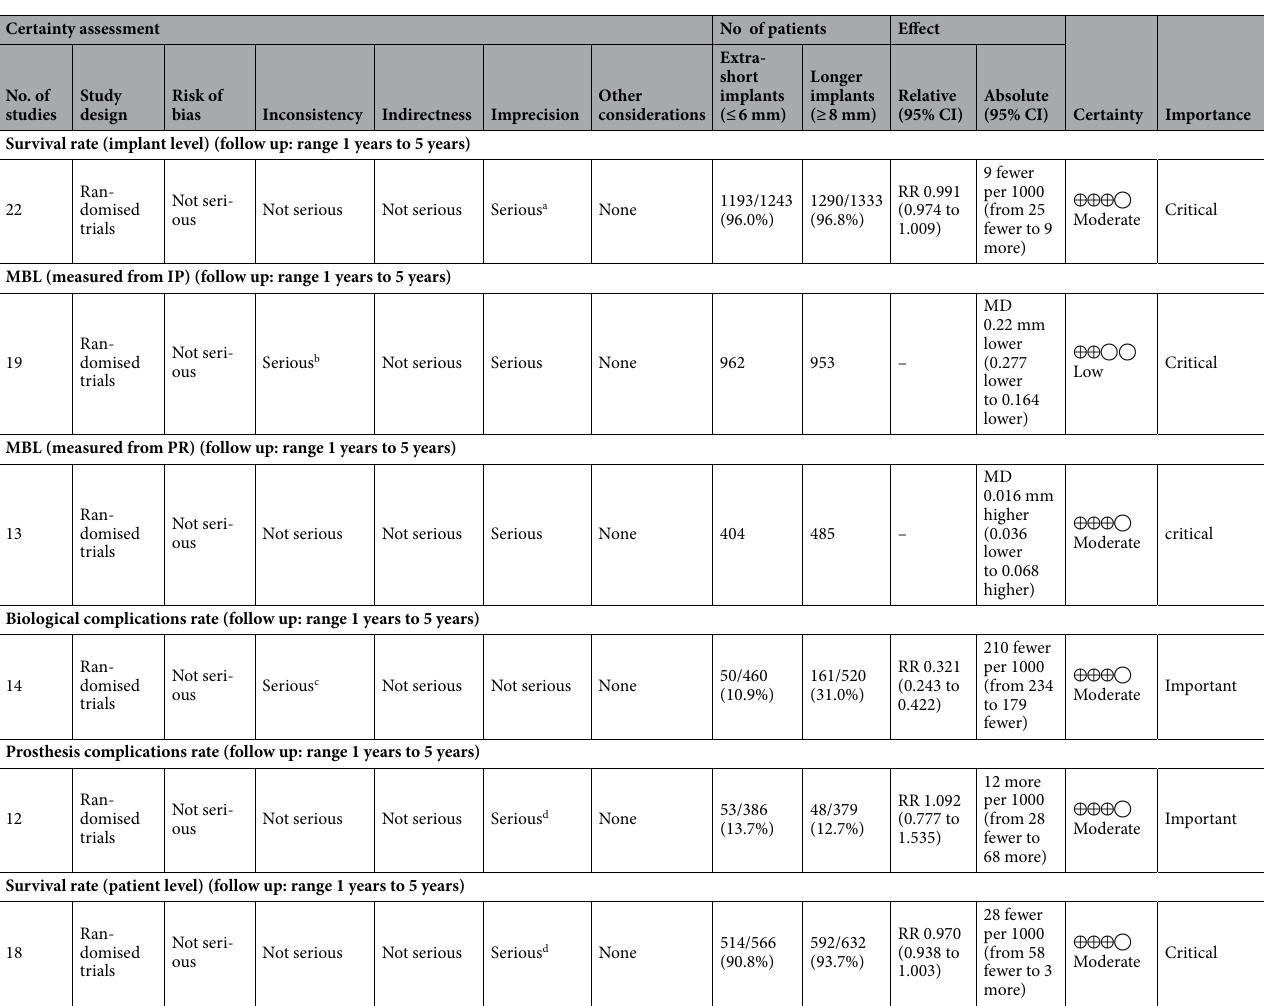
The sensitivity analyses for all studies in implant and patient level were performed respectively, as well as the studies with correct statistical analyses (Fig. 6a–c). Figure 6a showed that the exclusion of Bernardi et al. 54